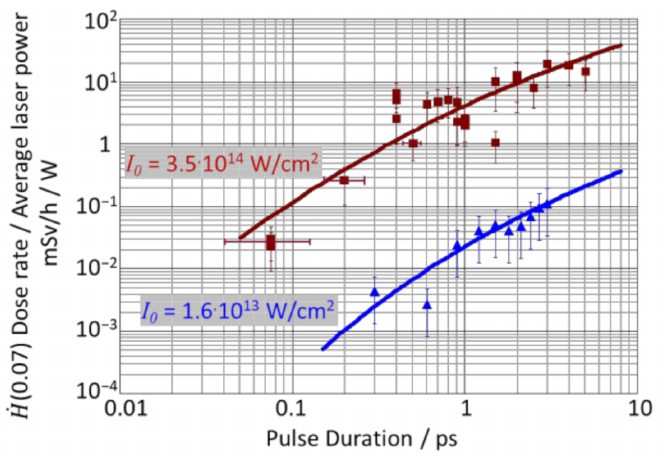
. H (0.07) dose rates divided by the incident average laser power as a function of Figure 1. Measured the pulse duration for a constant irradiance of 3.6 × 10 14 W/cm 2 (squares) and 1.6 × 10 13 W/cm 2 (triangles). The dose rates were measured with an OD-02 dosimeter at a distance of 25 cm (red squares) and 20 cm (blue triangles). The irradiance was kept constant by adapting the pulse energy. The solid lines were calculated with the extended model given in Equation (9) using the values of the respective experimental